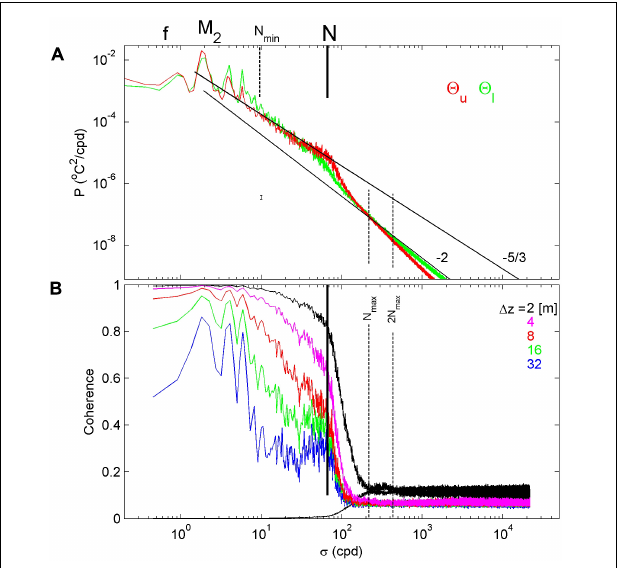
FIGURE 8 | Spectral comparison of moored T-observations from MS. (A) Power spectra, heavily smoothed ∼ 1000 dof for upper 50 (red) and lower 50 sensors (green). (B) Coherence level between all possible non-overlapping pairs of T-sensors, over vertical distances as given. The 95% confidence level is indicated by the dashed line for (cid:49) z < 2 m near the bottom (always coh lev < 0.16). N max here also marks where coh-lev first drops into